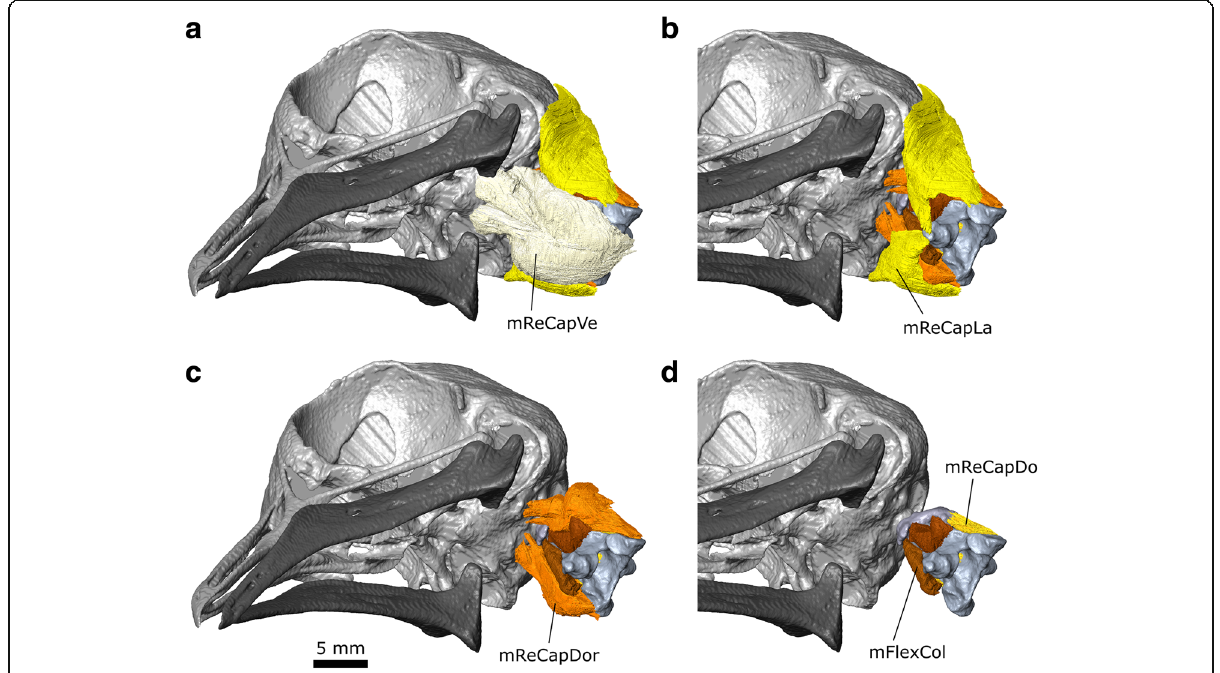
Fig. 18 The anterior hypaxial muscles of Columba livia in ventral view. a to c represent increasingly deep